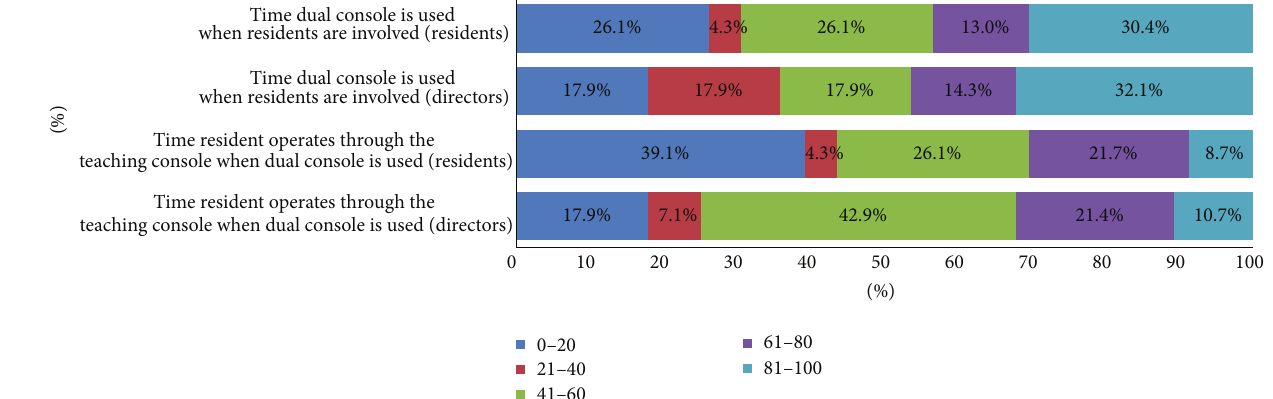
Figure 1: Involvement of residents during robotic operations using the dual console, based on perceptions of graduating obstetrics and gynecology residents and program